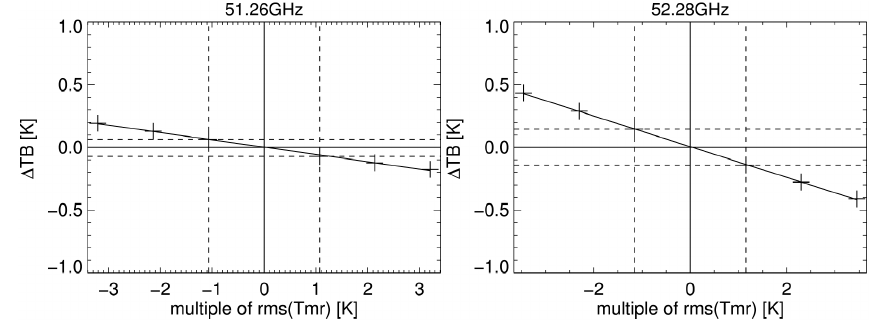
Fig. 7. Sensitivity of calibrated T b to uncertainties in the T mr calculations. Crosses: 1T b resulting from a T mr varied by ± 3RMSE( T mr ) (RMSE=Root Mean Square Error), solid line: linear fit, dashed: uncertainty area of one RMSE( T mr ) and the resulting uncertainty of T b . The RMSE (T mr ) is 1.3K (51.26GHz) and 1.4K